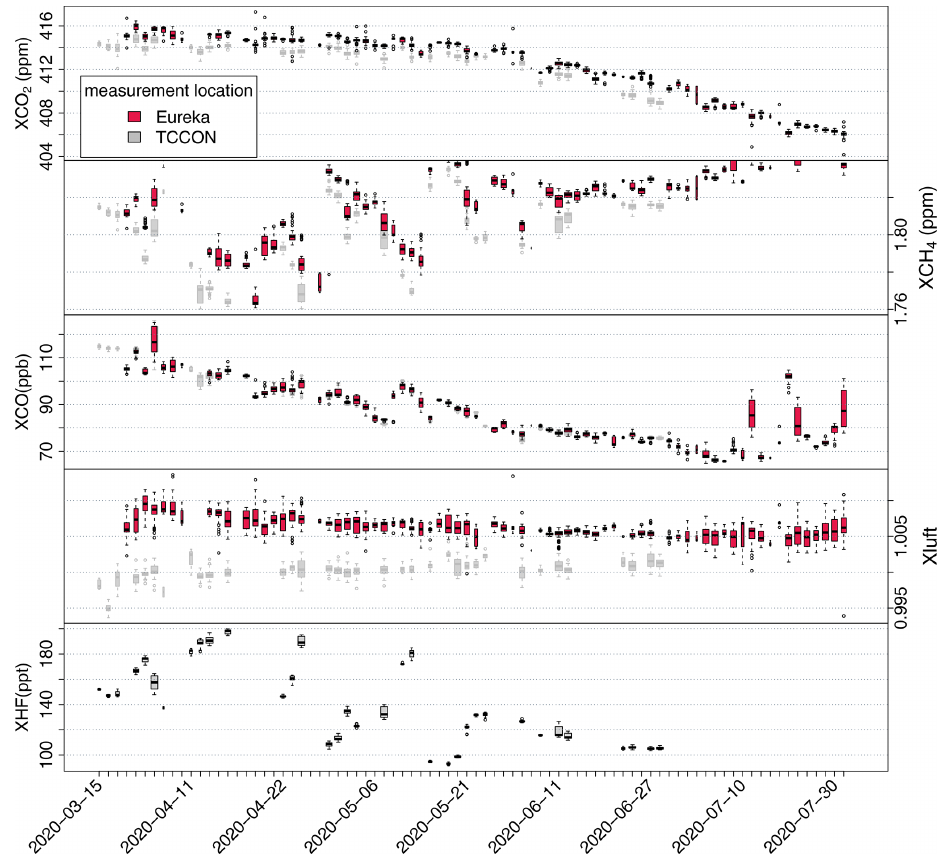
Figure 10. Time series of EM27/SUN (tb) and co-located TCCON retrieved XCO 2 , XCH 4 , XCO, Xluft, and XHF (TCCON only) during the spring and summer 2020 Eureka campaign (GGG2020). The box plot width is proportional to the number of observations collected in each day. The line inside each box represents the median value for each day, and the bars show the daily range, excluding the outliers. Outliers are depicted as